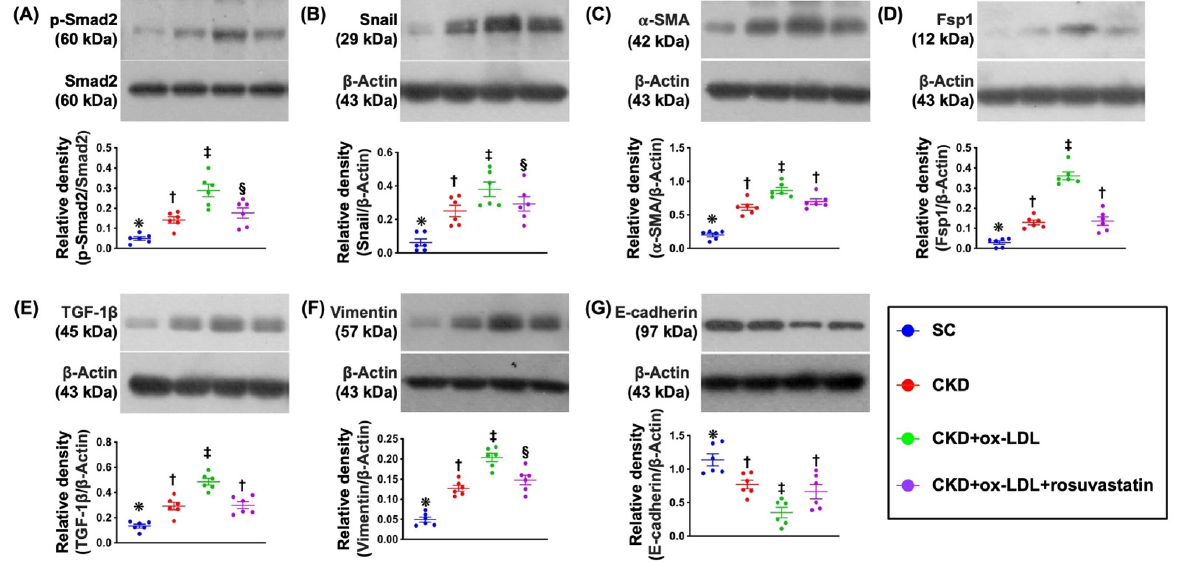
Figure 6. Protein expressions of EMT biomarkers in kidney parenchyma by day 42 after CKD in- duction. ( A ) Protein expression of phosphorylated (p)-Smad2, * vs. other groups with different